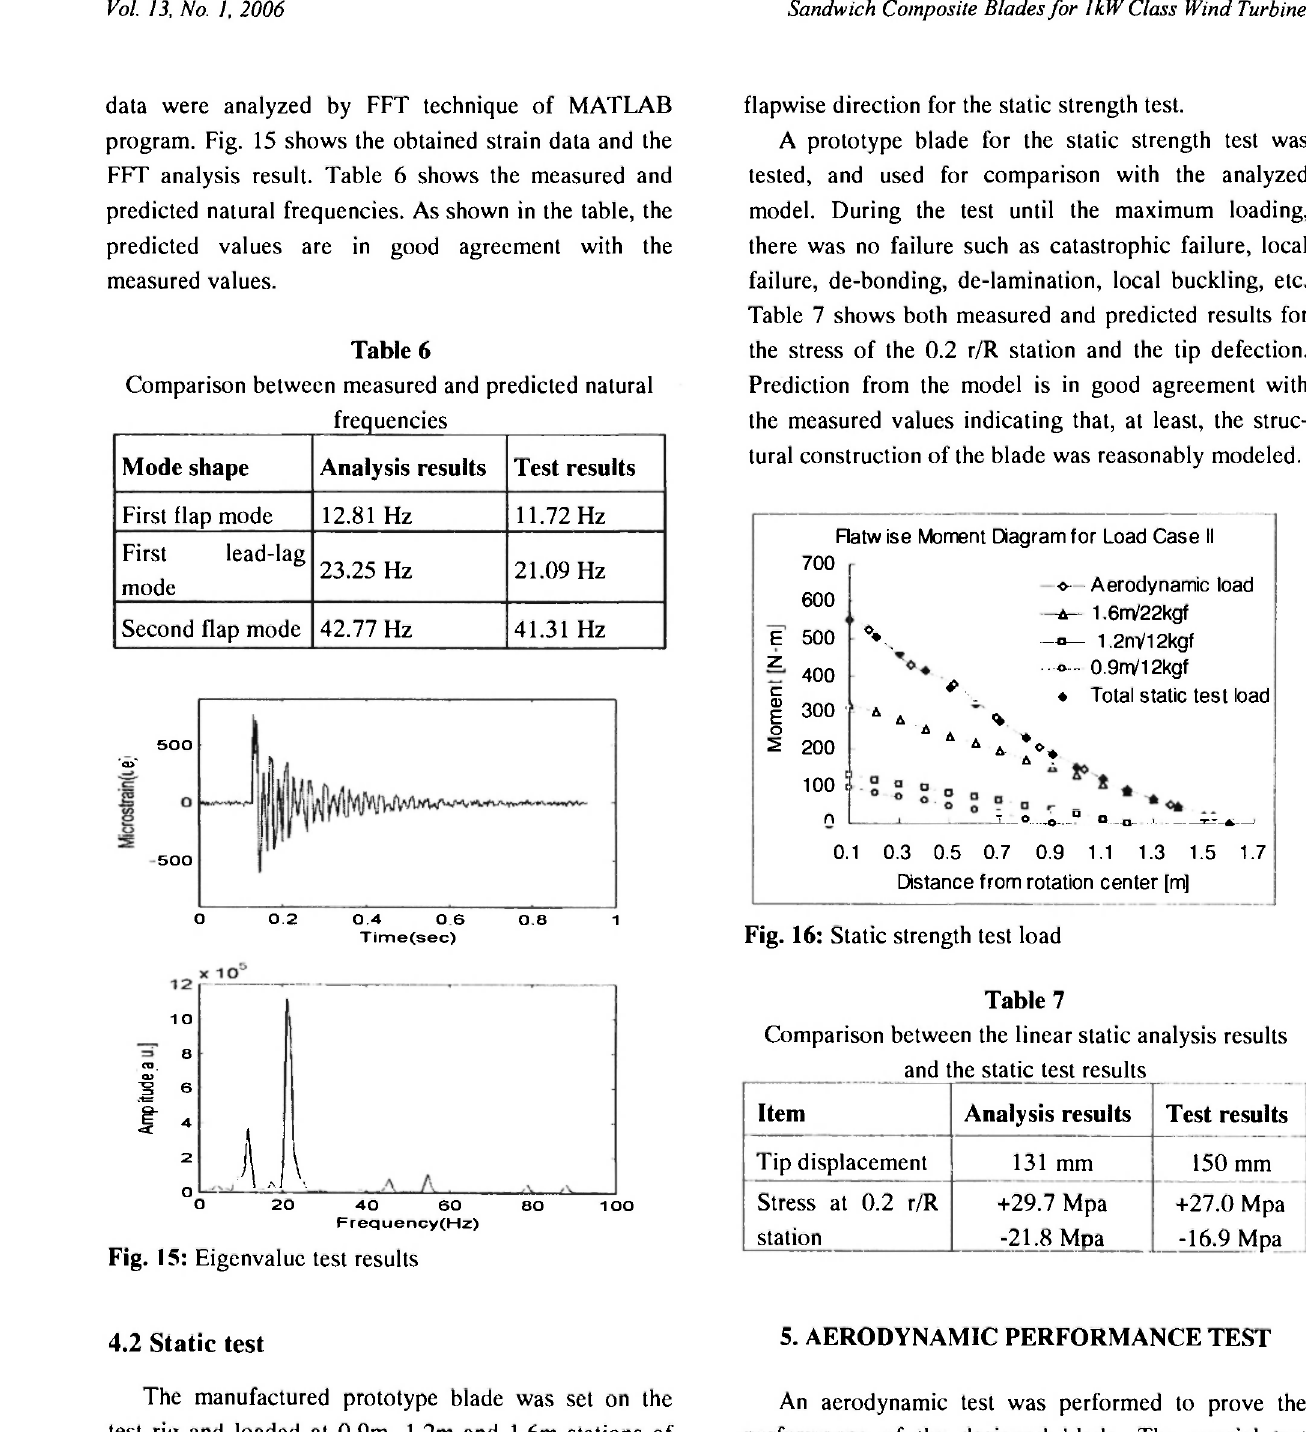
Fig. 15: Eigenvalue test results